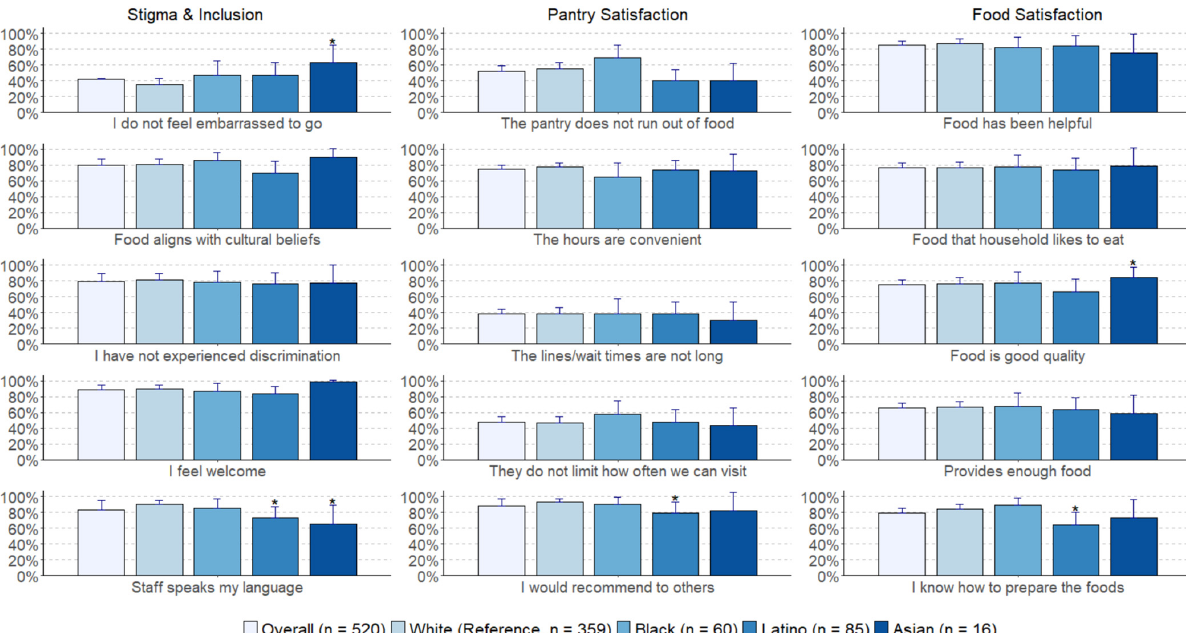
Figure A2. Barriers to food pantry use among food-insecure adults not using pantries during the COVID-19 pandemic. Chi-square tests were performed for each statement for each racial/ethnic group compared to the white reference group; * indicates a p -value < 0.05.